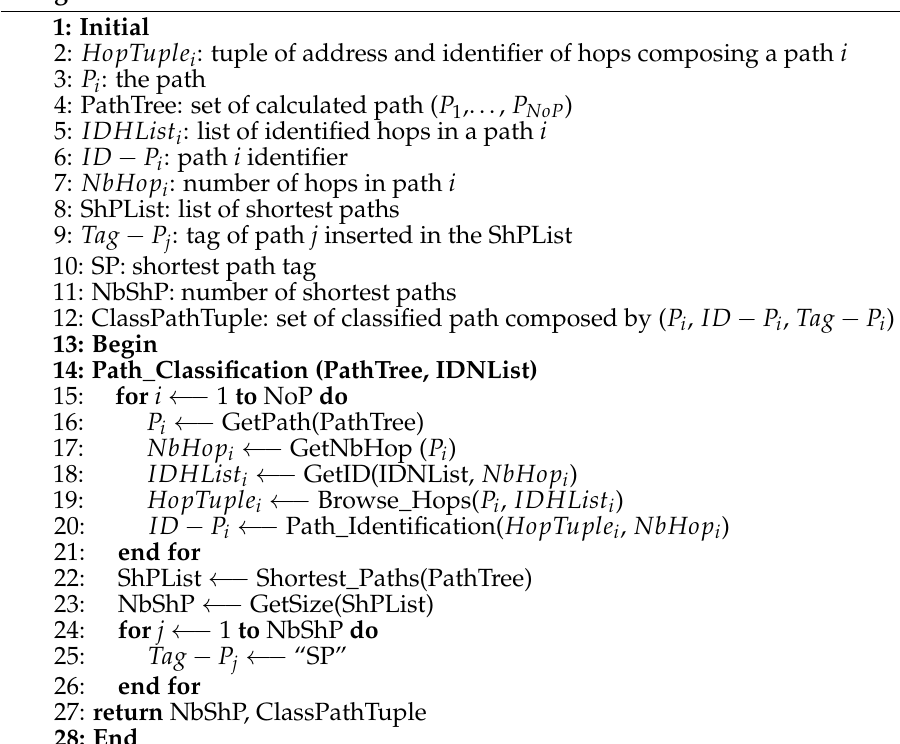
Algorithm 3: Path classification